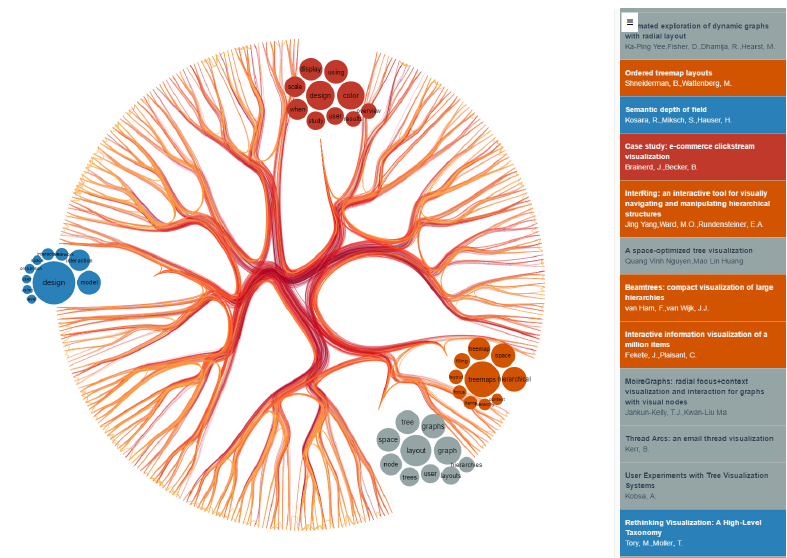
Figure 12. Edge bundling layout summarization by collapsing backbone branches. A circle pack representation contains the most frequent terms found in four different groups of papers showed in the auxiliary list on the right. The color of each entry identifies the group each paper belongs